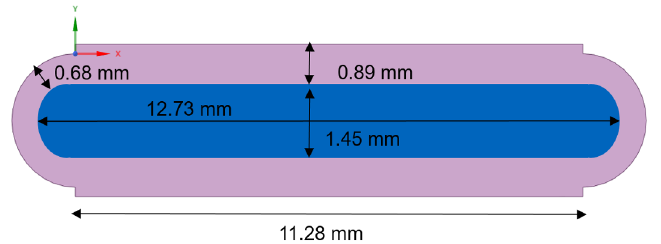
Figure 1: Cross-section of the aluminum test section used in the Gambill and Bundy experiment. The dimensions of the aluminum channel are shown. The blue and light pink colors represent water and aluminum,